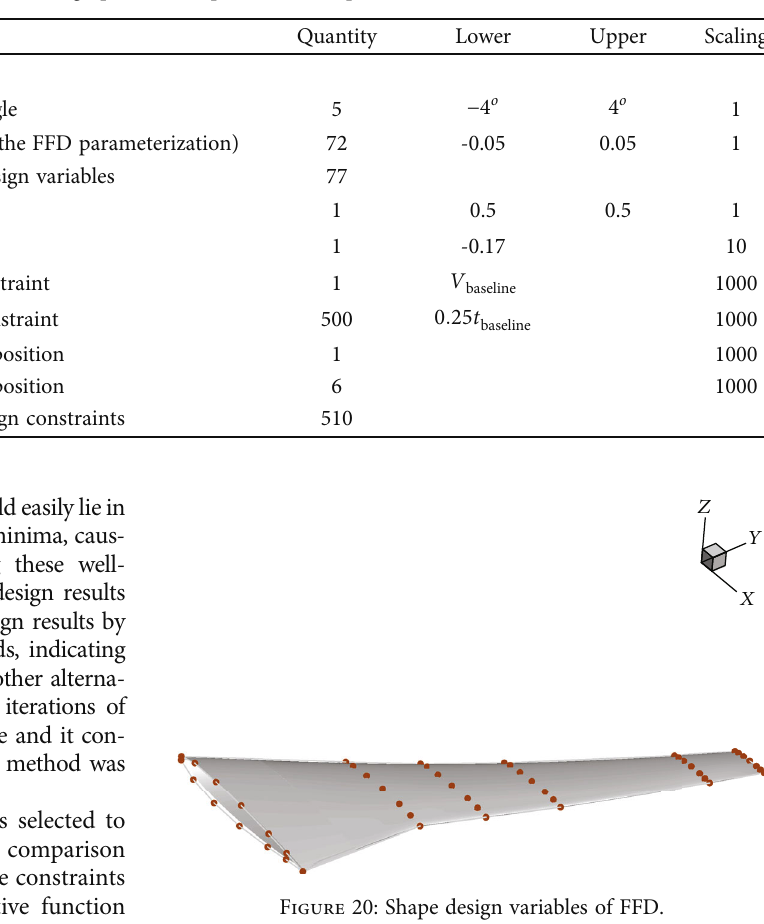
Figure 19: Baseline CRM wing scaled by its mean aerodynamic chord. Table 7: CRM wing optimization problem description.